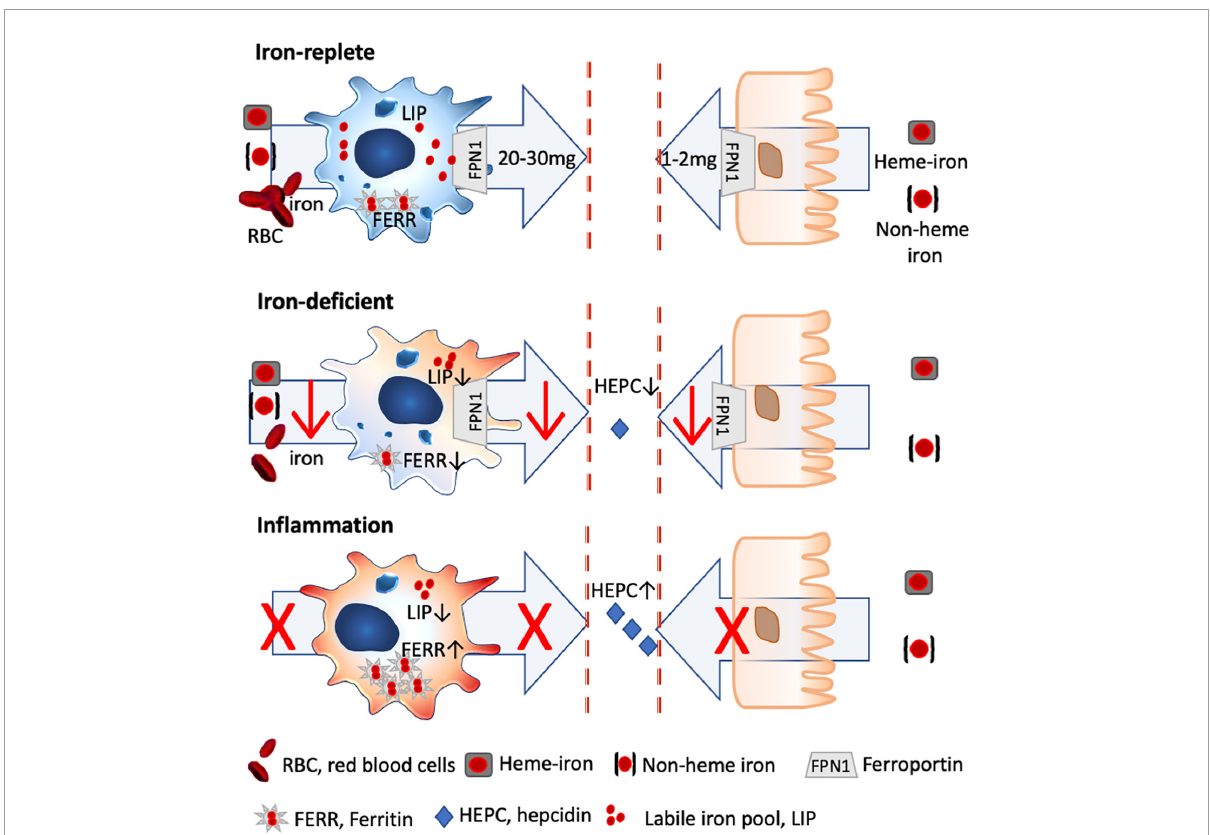
FIGURE1 Iron homeostasis in steady state and inflammatory conditions. Only 2 mg of dietary iron is absorbed via the gut daily, with the bioavailability of heme iron being about 5 × greater than non-heme iron. In contrast, 20–30 mg of iron is recycled iron from senescent red blood cells by splenic macrophages, which are characterized by a high iron turnover rate with a large labile iron pool (LIP) and low ferritin levels (FERR). Under iron-deficient conditions, less iron is absorbed via the gut and macrophages shift toward a more activated status, as iron through-put and thus metabolically active iron is low (low LIP), while FERR is also low. Under inflammatory conditions, hepcidin is excreted which degrades ferroportin, with the result that dietary iron uptake is hampered. Likewise, macrophages stop further iron acquisition and export and store the available iron into FERR, with the result that inflammatory macrophages have a low LIP, while FERR is